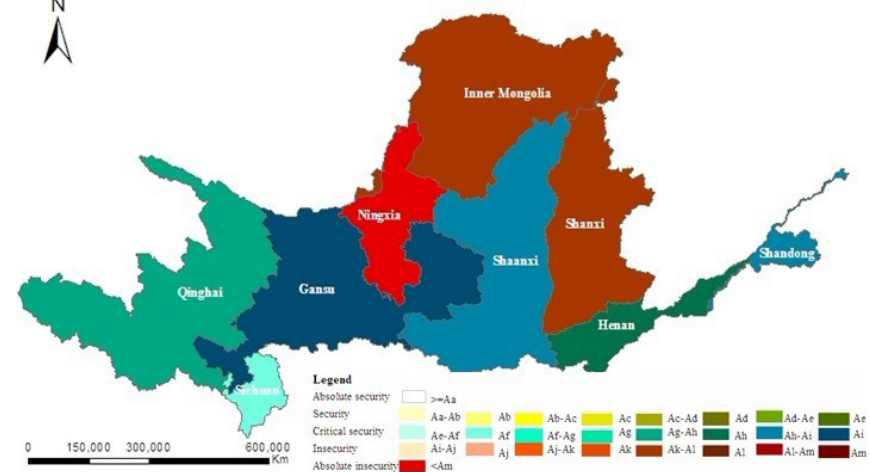
Fig. 4. Copeland aggregation results in the nine provinces.